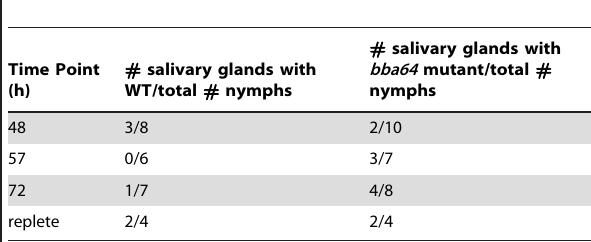
Table 1. Immunofluorescent imaging of B. burgdorferi in nymphal salivary